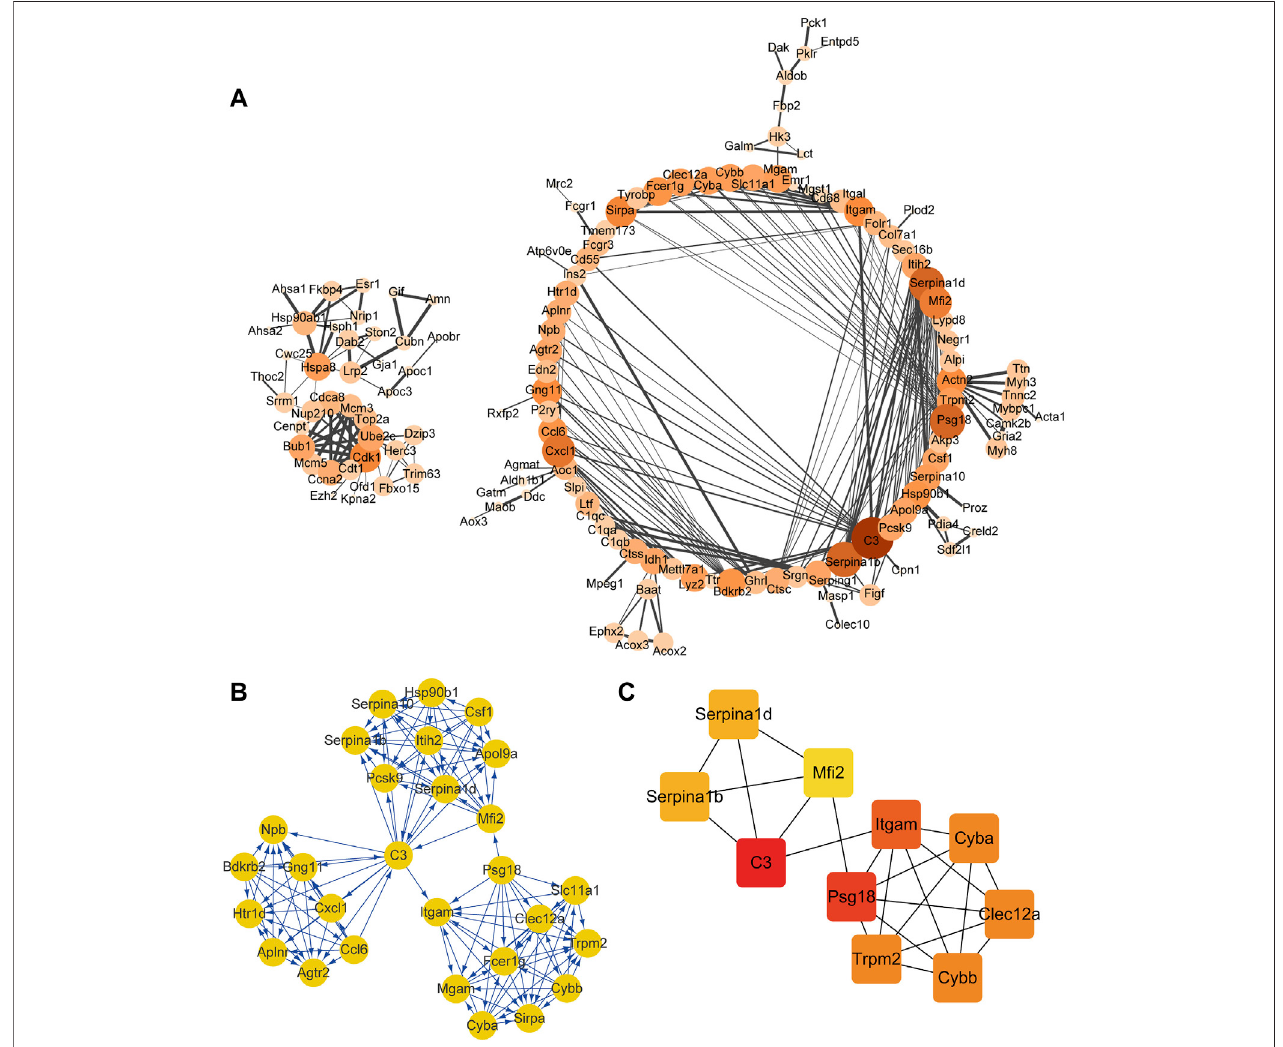
FIGURE1| PPInetwork(con fi dencescore ≥ 9)andhubgeneanalysisintheplacenta.PPInetworkanalysis (A) ,MCODEclusterofPPInetworks (B) ,andthetop10 hubgenes (C) intheplacenta.Thecolorofthenoderepresentstheclusteringcoef fi cient.Thesizeofeachnodeisproportionaltothenumberofdegrees.Interactionsare indicated by edges, with thicker edges having stronger associations. Different colors represent the different importance of the hub genes, in terms of their degree of connectivity. Higher ranks are represented by a deeper color.